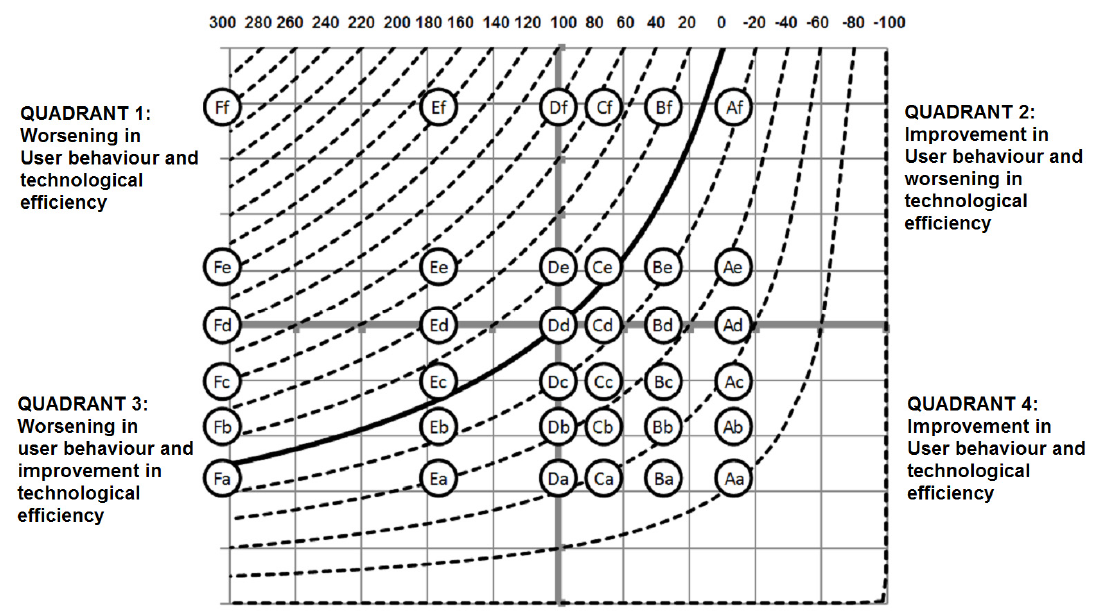
Figure 4. Domestic demands through behavioural and technological changes (Futures Framework approach, contours at 20% intervals).